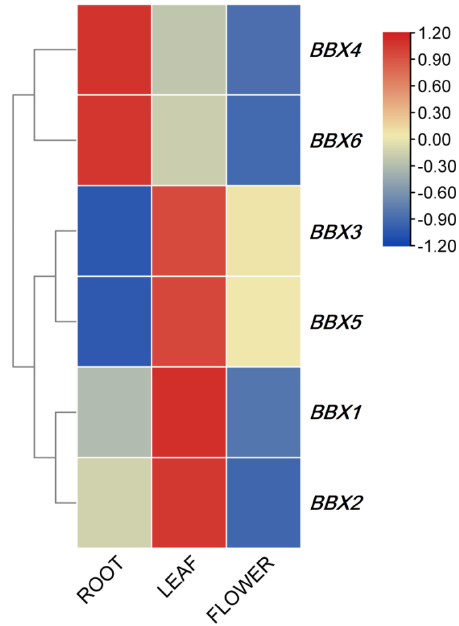
Figure 4. Expression profiles of IgBBX genes in various tissues. Blue and red indicate down-regu- lated and up-regulated transcript abundance, respectively, compared to the relevant controls (root). Bar on the top right corner represents log 2 transformed values.